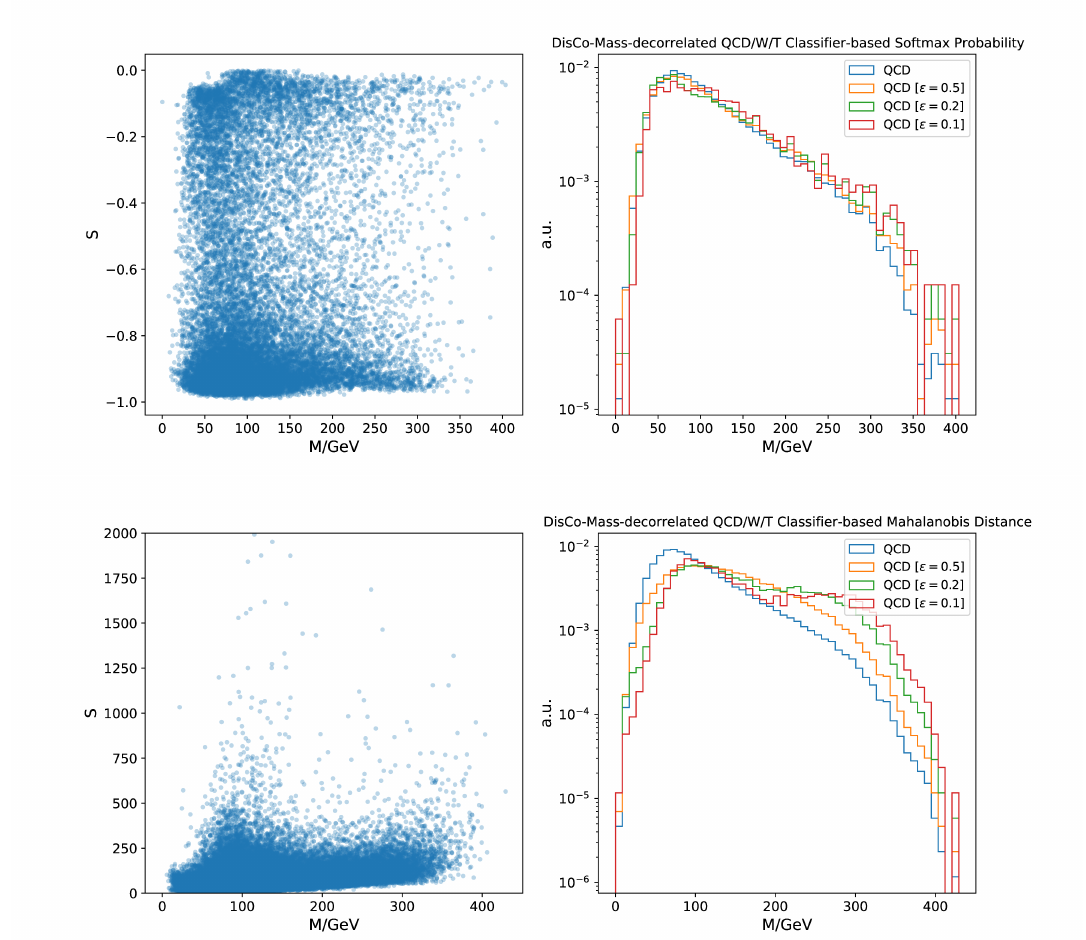
Figure 15 . DisCo( λ = 100 ) Model. Top : The mass-decorrelated model with p QCD as the anomaly score. Bottom : The mass-decorrelated model with the Mahalanobis distance as the anomaly score. Left : The correlation between jet mass M and the anomaly score. Right : Mass distributions for different background acceptance rates ( (cid:15)